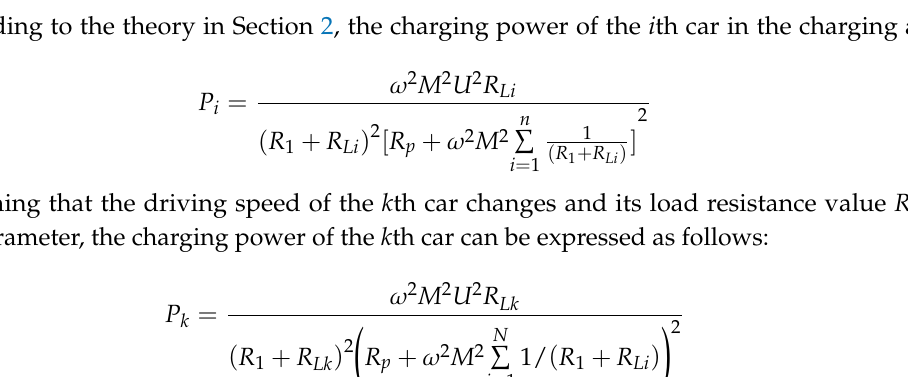
Figure 6. Influence of U and R L on charging power per EV P.